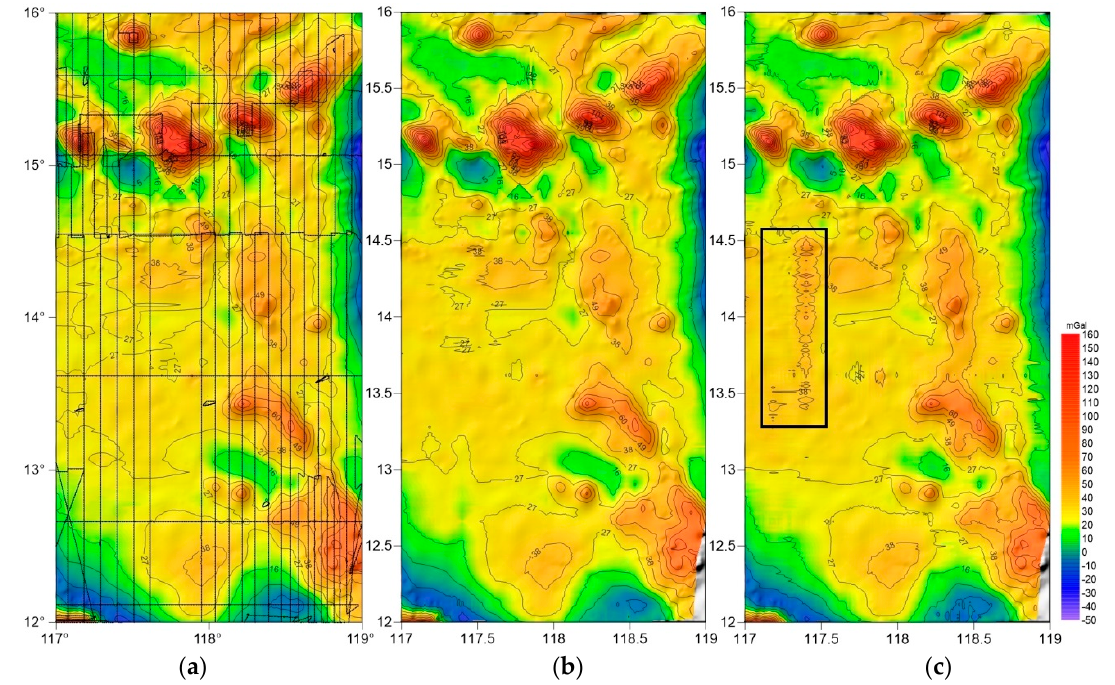
Figure 9. ( a ) SAG-2M gravity anomaly map before profile division; ( b ) SAG-2M profile data gravity anomaly map; ( c ) S-129 gravity anomaly map.